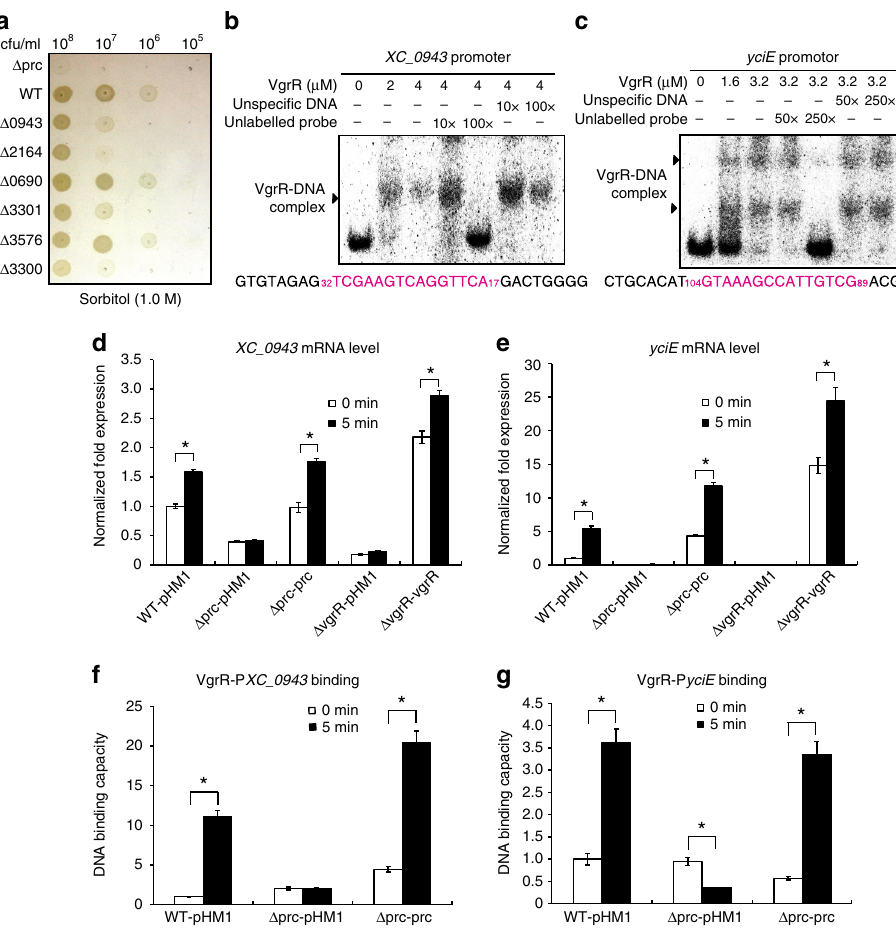
Fig. 8 Prc regulates the VgrR – promoter-binding interactions in bacterial cells. a Bacterial growth on NYG – sorbitol plate. Bacterial cultures were serially diluted and inoculated onto NYG plus 1.0 M sorbitol plate and grown for 72 h at 28 °C. The experiment was repeated three times. b and c Electrophoretic mobility shift assays revealed that VgrR directly bound the promoter regions of XC_0943 and yciE . PCR products of the promoter regions were labelled with [ γ - 32 P]ATP and used as DNA probes. Unlabelled DNA and non-speci fi c DNA were used as competitors. The sequence of the DNA probe is shown below with the VgrR-binding motif in magenta. Numbers indicate the location relative to the translation initiation site. Each experiment was repeated two times. Triangles indicate VgrR – DNA complexes. d and e The prc mutation caused decreases in the transcription levels of XC_0943 and yciE when bacterial strains were grown under osmostress. qRT-PCR was used to quantify the mRNA levels of these genes in different bacterial strains before and after osmostress stimulation (1.0 M sorbitol, 5 min). Ampli fi cation of the cDNA of tmRNA was used as an internal control. A representative of three independent experiments is shown. f and g The prc mutation caused decreases in VgrR – DNA binding in bacterial cells. ChIP-qPCR was conducted to quantify the enrichment of VgrR at the promoter regions of XC_0943 and yciE in vivo when bacterial strains were grown under osmostress conditions (NYG medium plus 1.0 M sorbitol for 5 min). The experiment was repeated three times. In d – g Error bars indicate the standard deviations. Asterisks indicate signi fi cant differences of strains before and after osmostress (Student ’ s t -test, P <